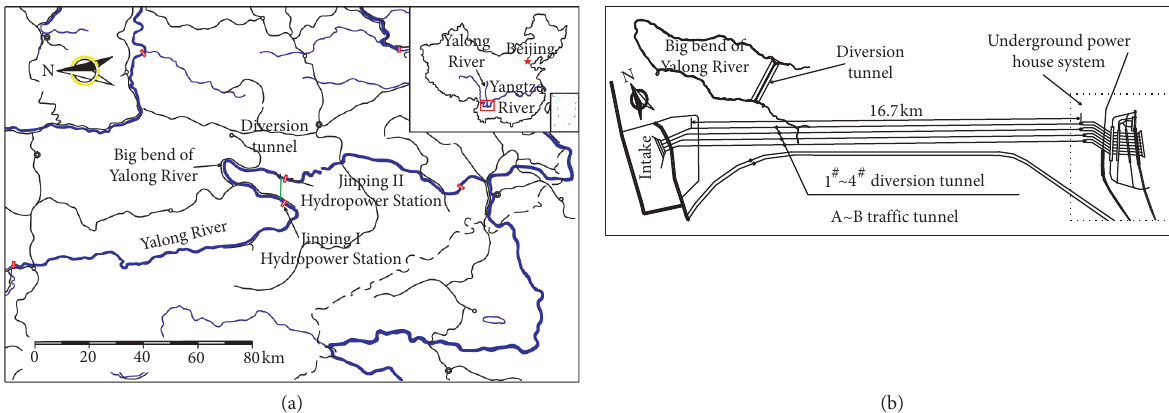
Figure 1: Location of the Jinping II diversion tunnels: (a) location of the Jinping II Hydropower Station and (b) location of the diversion tunnels.